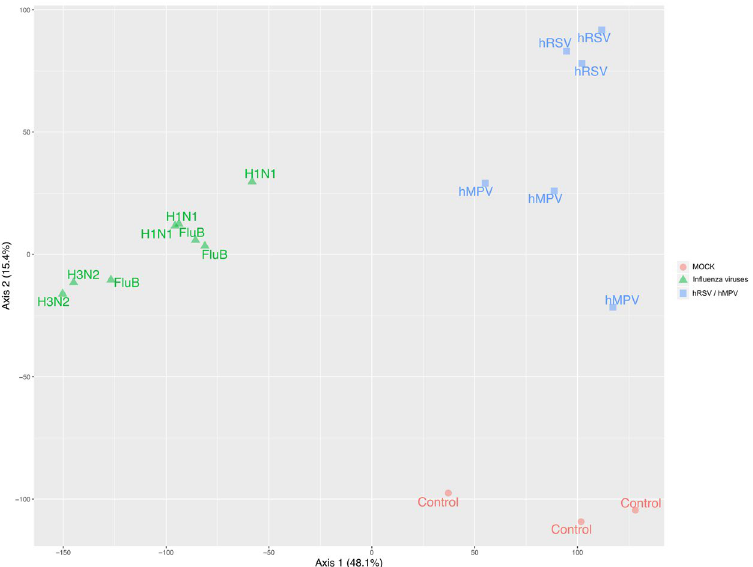
Figure 3. Principal component analysis (PCA) plot depicts significant differences between virus-induced transcriptomic signatures. Abundances in TPM (Transcripts Per Kilobase Million), counts and metadata were combined in a raw expression matrix. HAE infected by viruses belonging to the Orthomyxoviridae family (H3N2, H1N1, FluB) are color-coded in green, hMPV and hRSV in blue and mock-infected in red. The component 1 accounts for 48.1% of the total variance of the dataset whereas the second one accounts for 15.4%. The PCA plot showed a distinct progression of differential gene expression mainly between control – influenza and hRSV/hMPV conditions.